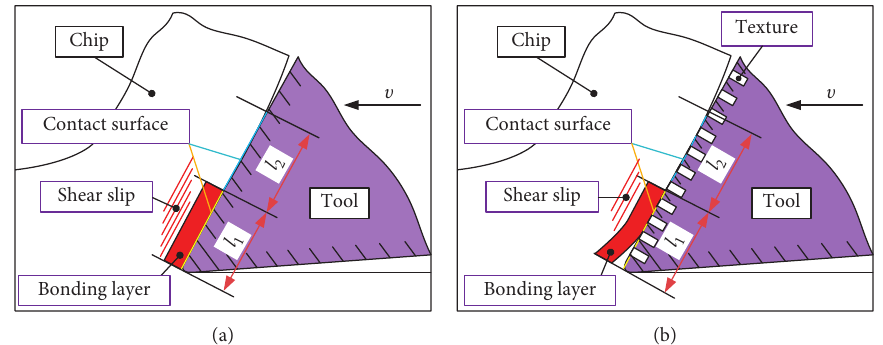
Figure 5: Schematic diagram of bonding between the chip and rake face. (a) Interface bonding of the tool without texture; (b) interface bonding of textured tools.